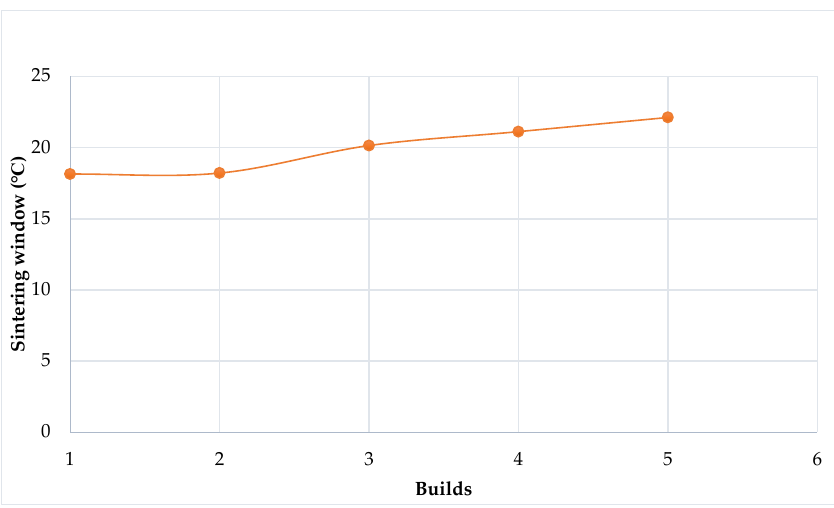
Figure 11. Melting points of PA 12 over seven re ‐ use cycles [19].